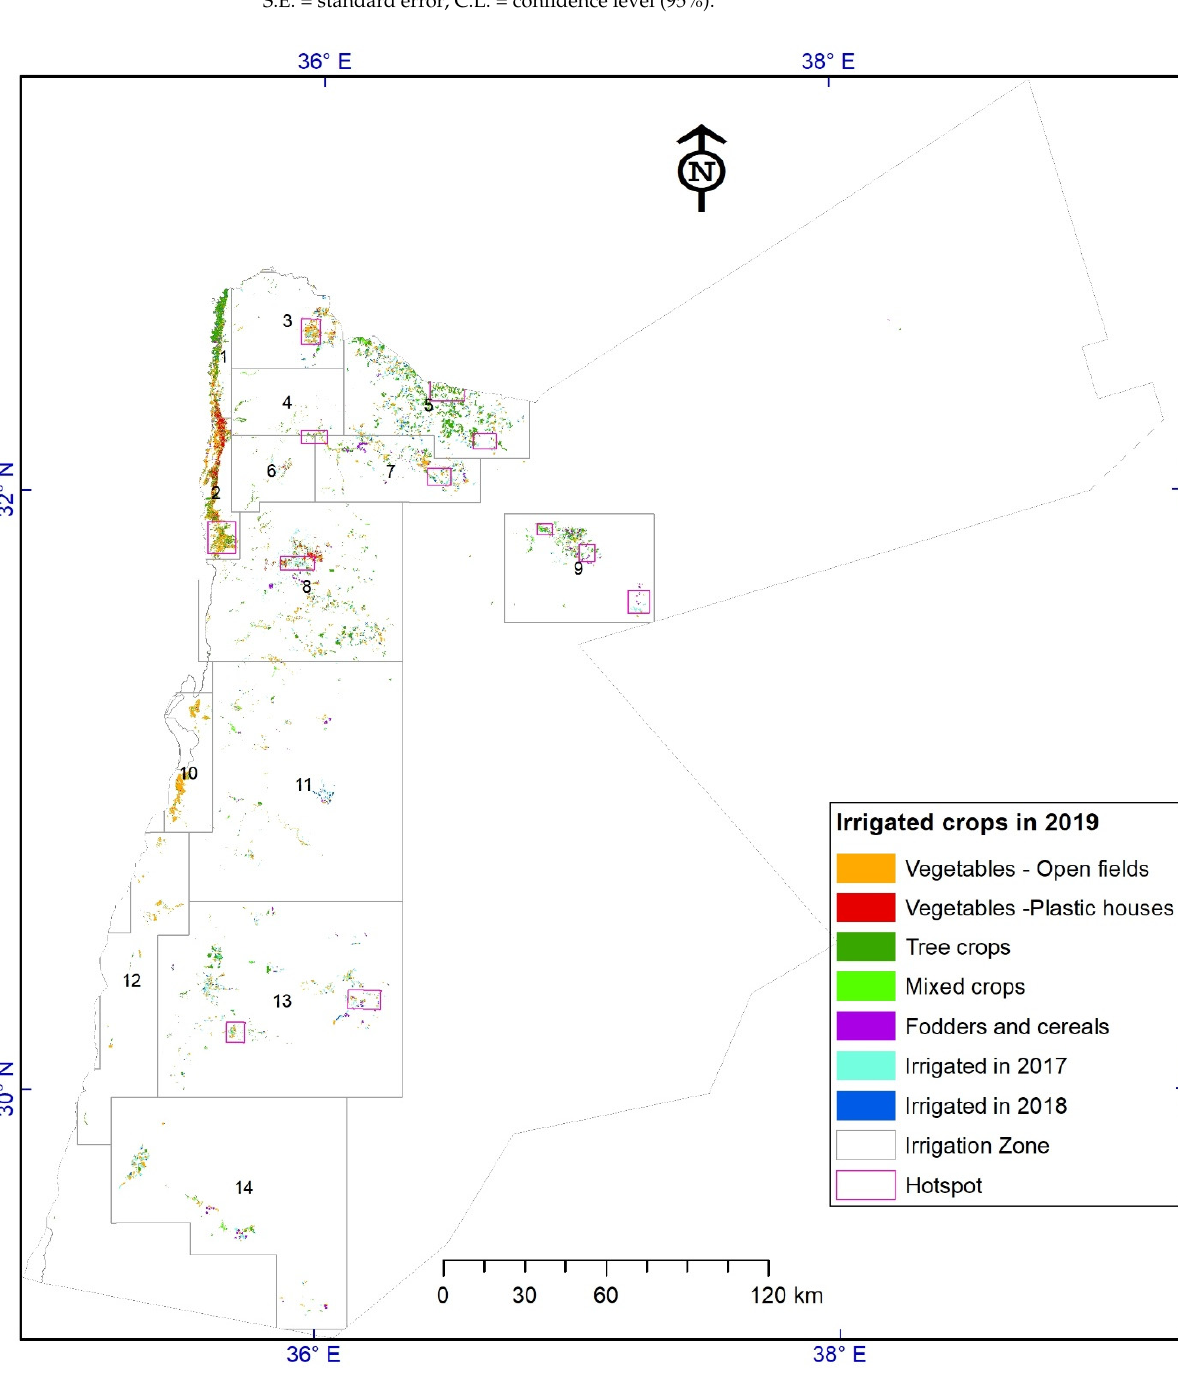
Figure 9. Map of irrigated crops in Jordan during 2017–2019 with the main irrigated zones and hotspots that have illegal access to water. hotspots that have illegal access to